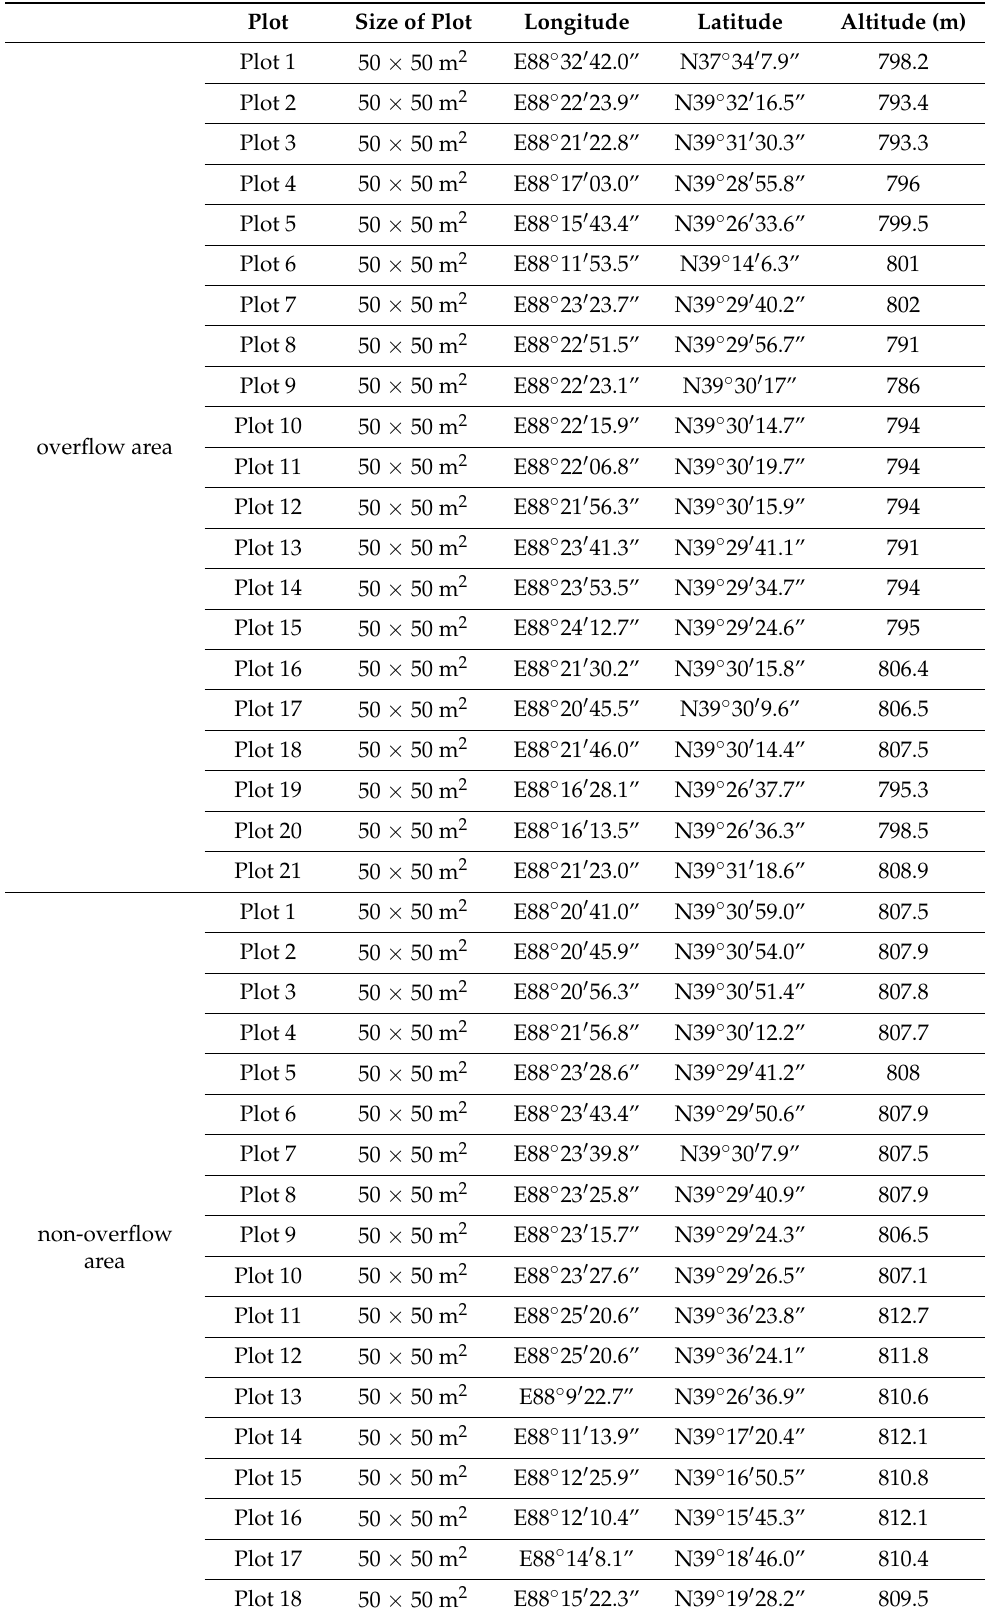
Table 1. Geographical location of the monitoring